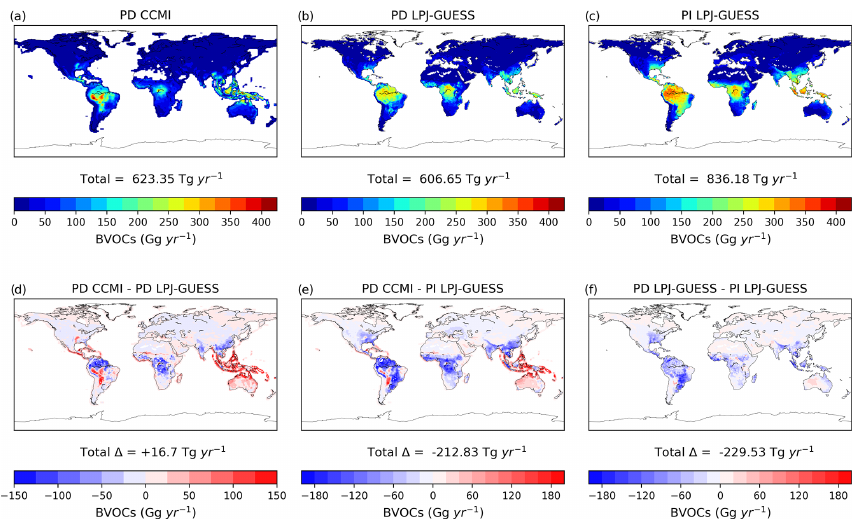
Figure 2. Annual BVOC (isoprene + monoterpenes) emissions at 1 ◦ × 1 ◦ resolution in the two present-day biogenic emissions inventories (CCMI and LPJ-GUESS) and the pre-industrial LPJ-GUESS inventory. (a–c) Total emissions per year and (d–f) differences between the three inventories. Total annual emissions and the difference in annual emissions are also